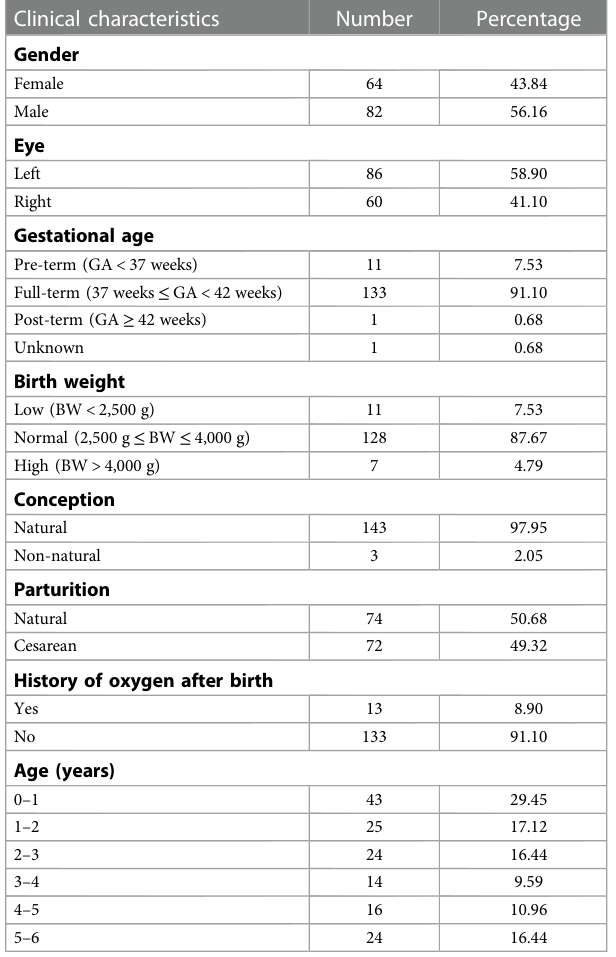
( Supplementary Table S1 ). When compared between females and males in each age group, females had bigger optic disc in the 2 – 3 years group (1.38 vs. 1.30, p = 0.030) and no signi fi cant